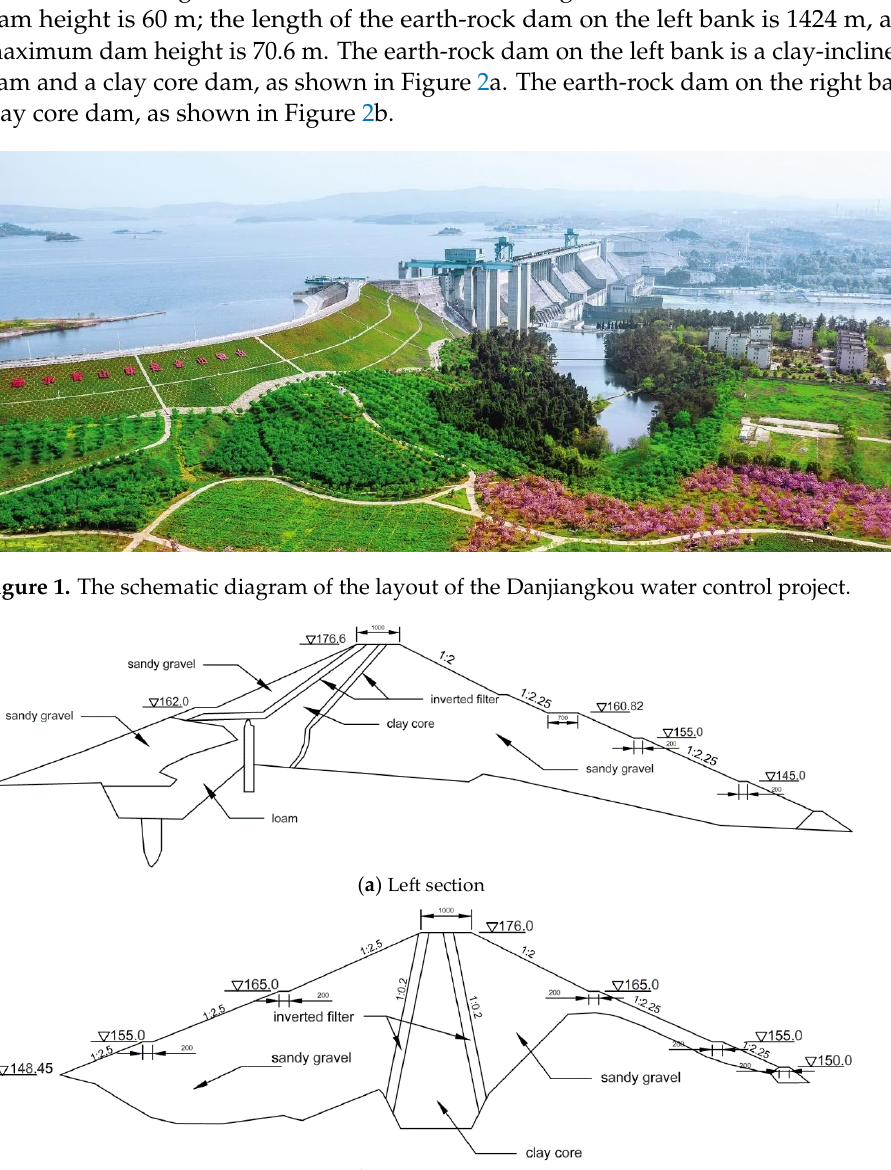
Figure 3. The locations of three measuring weirs. 3.2. Statistical Model